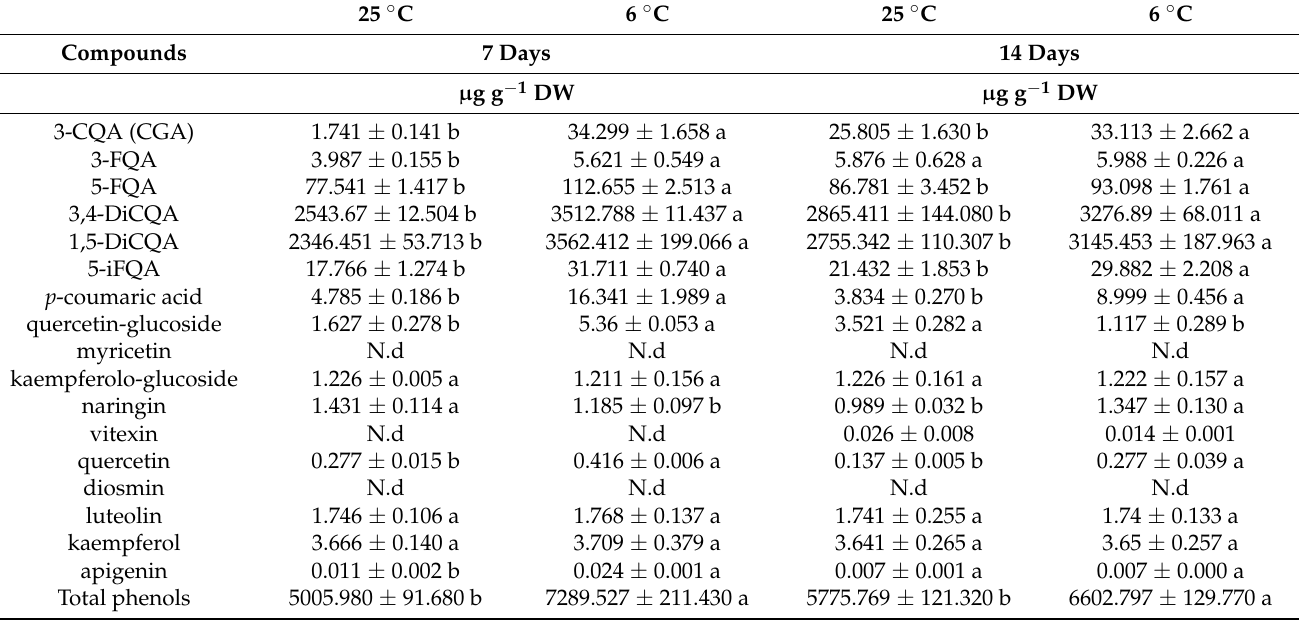
Table 1. Changes in polyphenol content measured by HPLC-MS analysis in cardoon callus cultures in response to 7 and 14 days of chilling stress at 6 ◦ C. Each value represents the mean of three biological replicates ± SD. Statistical significance for each compound within each time point was determined by using one-way ANOVA with Tukey’s post hoc test. Different letters indicate significant difference ( p -value <